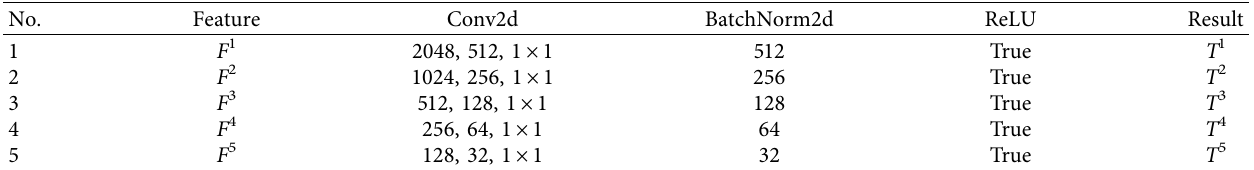
Table 1: Detailed parameters of three different operators, including convolutional operator, batch normalization operator, and ReLU operator, respectively. The left two parameters of Conv2d are the number of input and output channels, and the right two parameters are the kernel size. The parameter of the BatchNorm2d operator is the number of feature channels, and the parameter of the ReLU operator is in